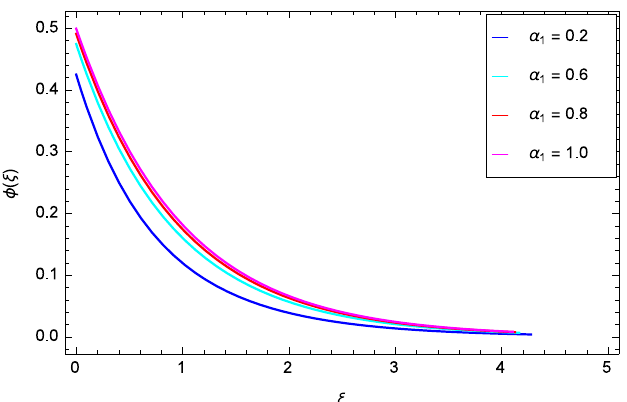
Figure 18. Impact of the curvature parameter α 1 on concentration φ ( ζ ) .